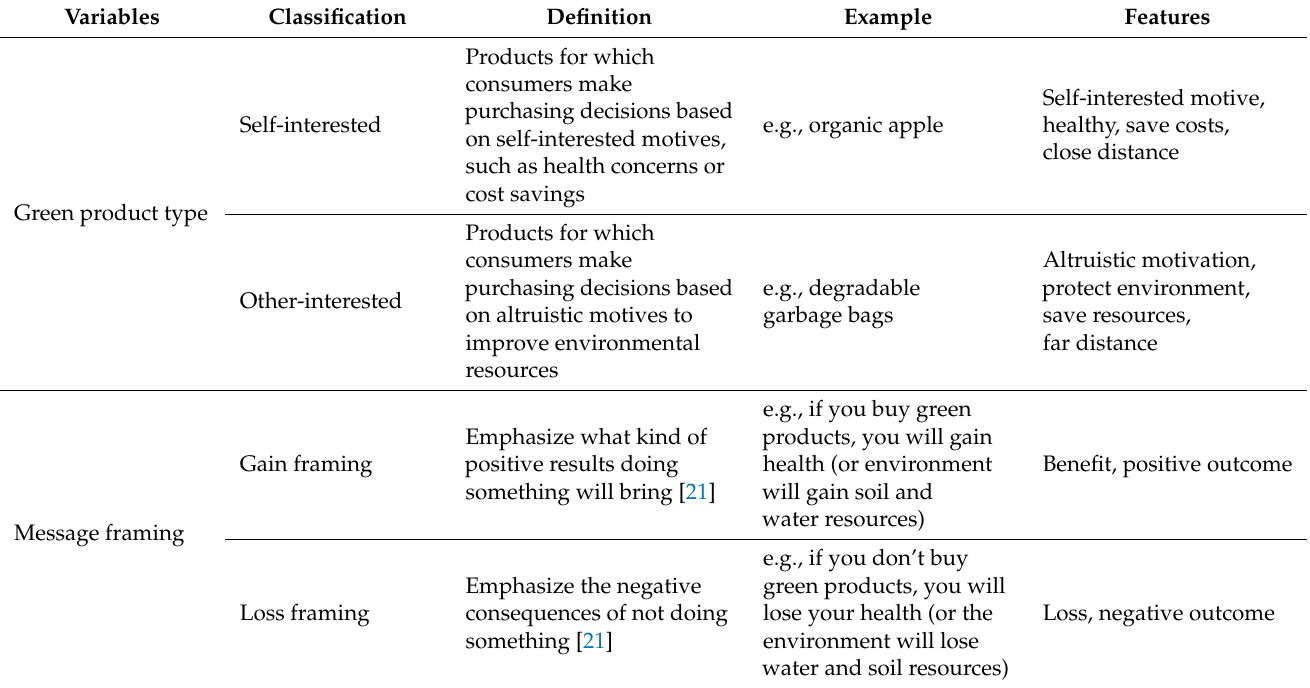
Table 1. Definition of variable and their